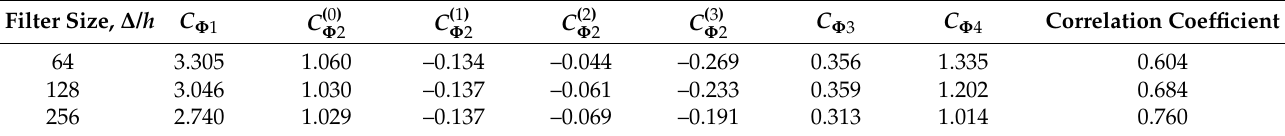
Table 3. Coefficients in the extended model (7), (13).